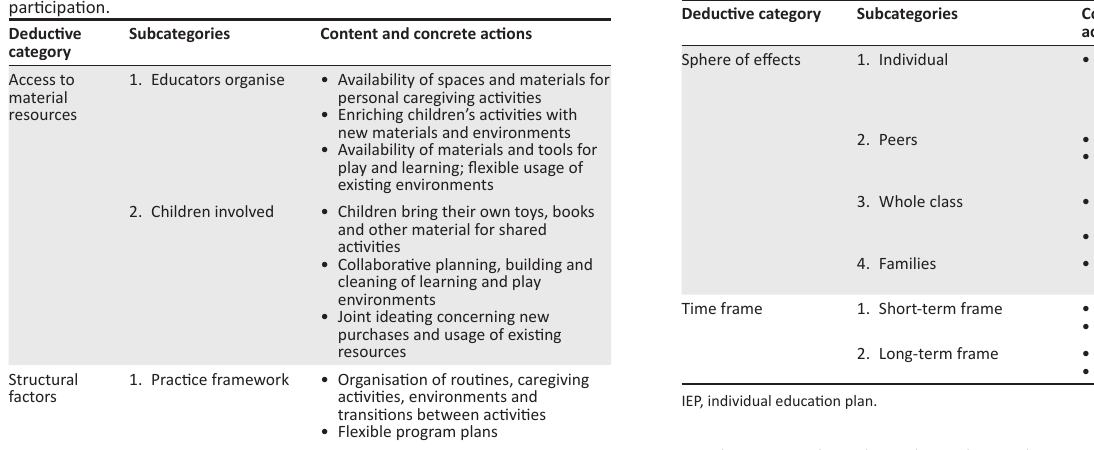
TABLE 5: Sphere of effects and time frame as participation